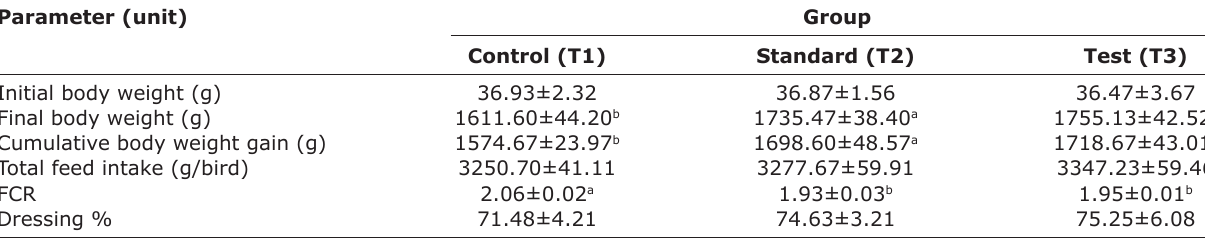
Table-4: The effect of supplementing CSE at 0.4 g/L in growth performance in broiler birds. Parameter (unit)